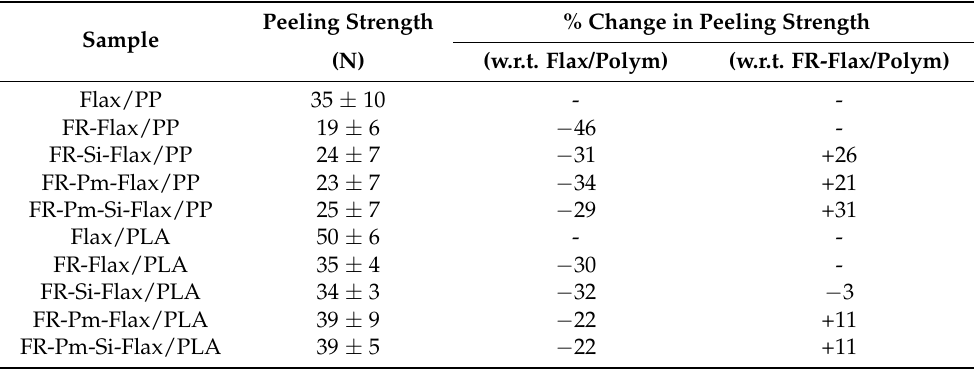
Table 5. Peeling test results of FR treated flax/PP and flax/PLA laminates.